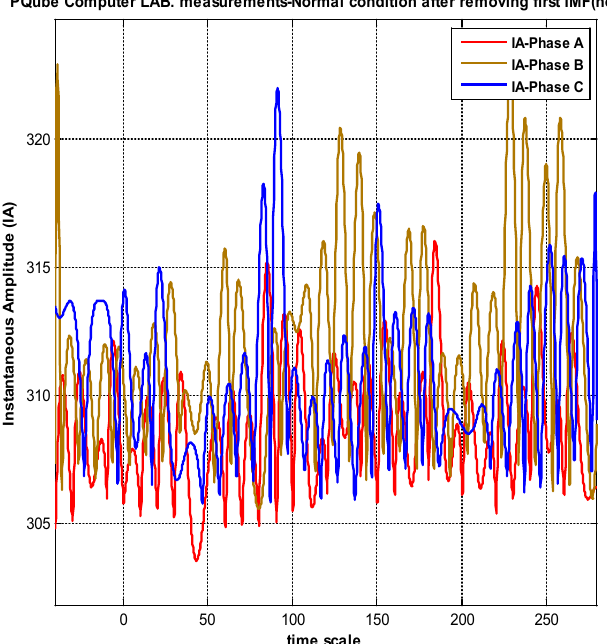
Fig. 9. IA corresponding to remove first imf normal condition of signal